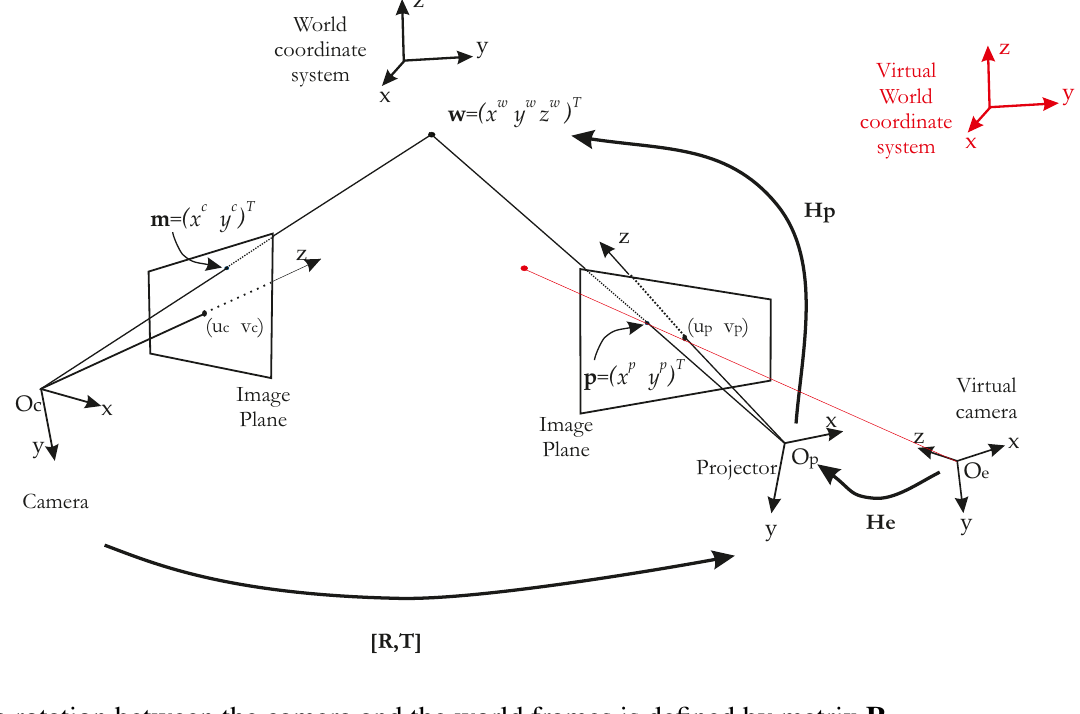
Figure 3. Projector-camera system modeling. A classical pinhole model is used for both devices. The two systems are related by the rigid motion matrix, [ R , T ]